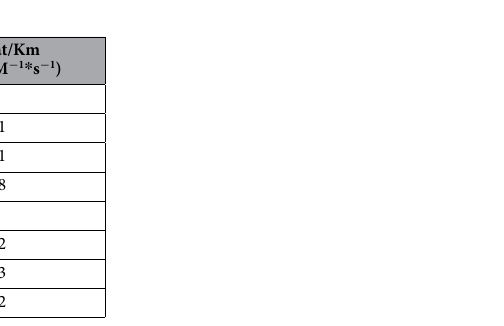
Table 1. Kinetic constants for Gr2 laccase and its mutants towards ABTS and